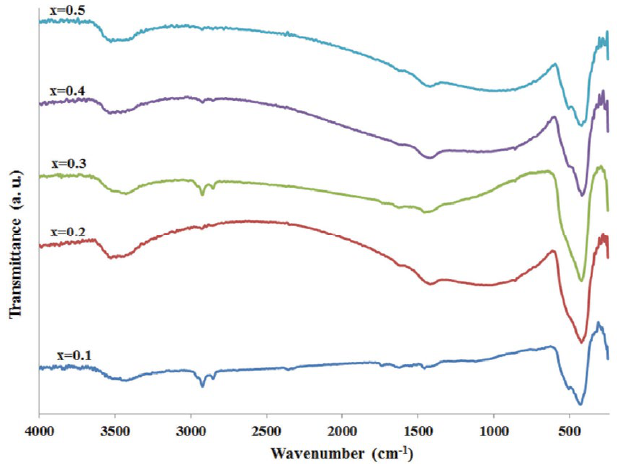
Fig. 6. FT-IR spectra of different CdO–ZnO samples